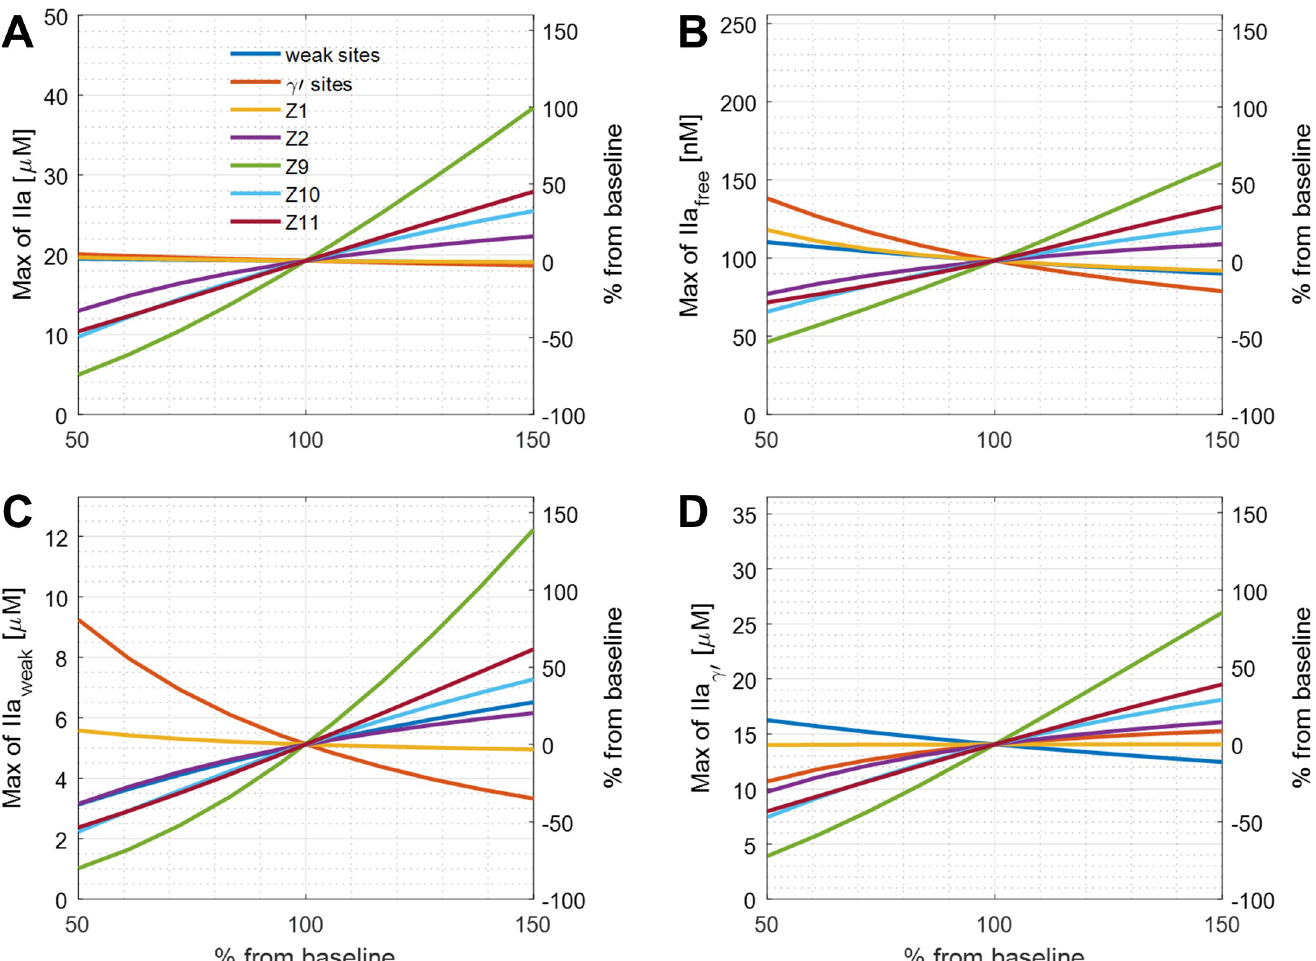
Fig 2. Local sensitivity analysis of total thrombin, free, and bound thrombin in the clot. The change of intrathrombus thrombin concentration on different sites due to the variation of plasma protein levels or thrombin binding sites on fibrin. The levels were changed one-at-a-time.